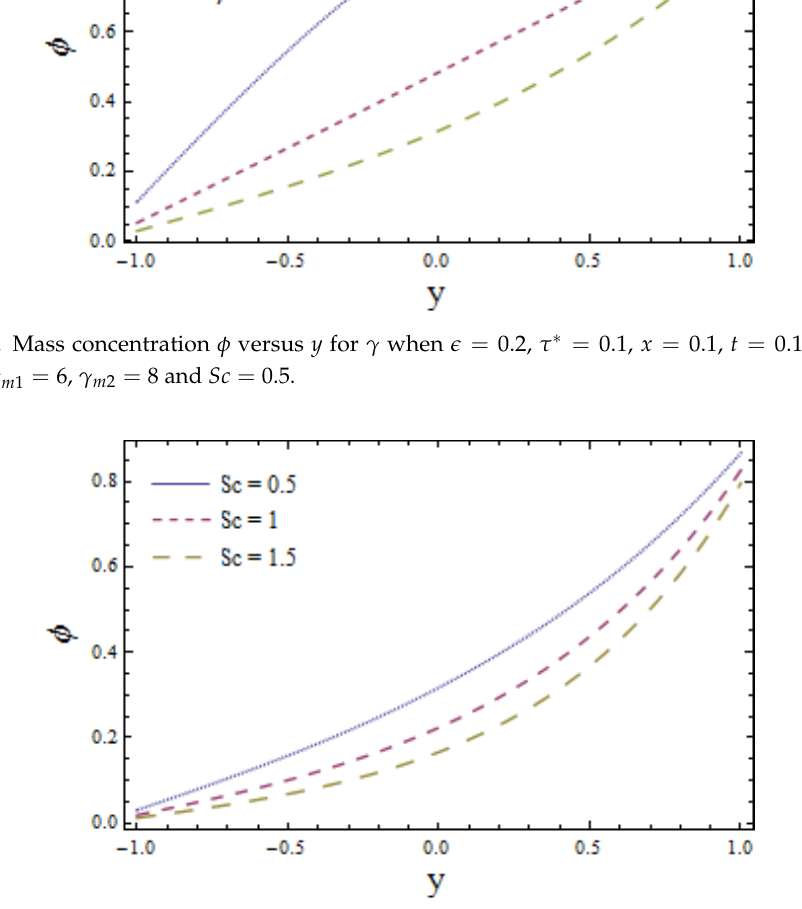
Figure 12. Mass concentration φ versus y for Sc when (cid:101) = 0.2, τ ∗ = 0.1, x = 0.1, t = 0.1, γ h 1 = 6, γ h 2 = 8, γ m 1 = 6, γ m 2 = 8 and γ =